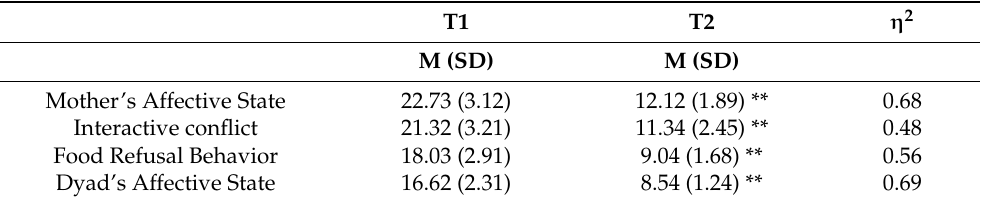
Table 1. Average scores and standard deviations of the SVIA subscales and general quality of mother–child feeding